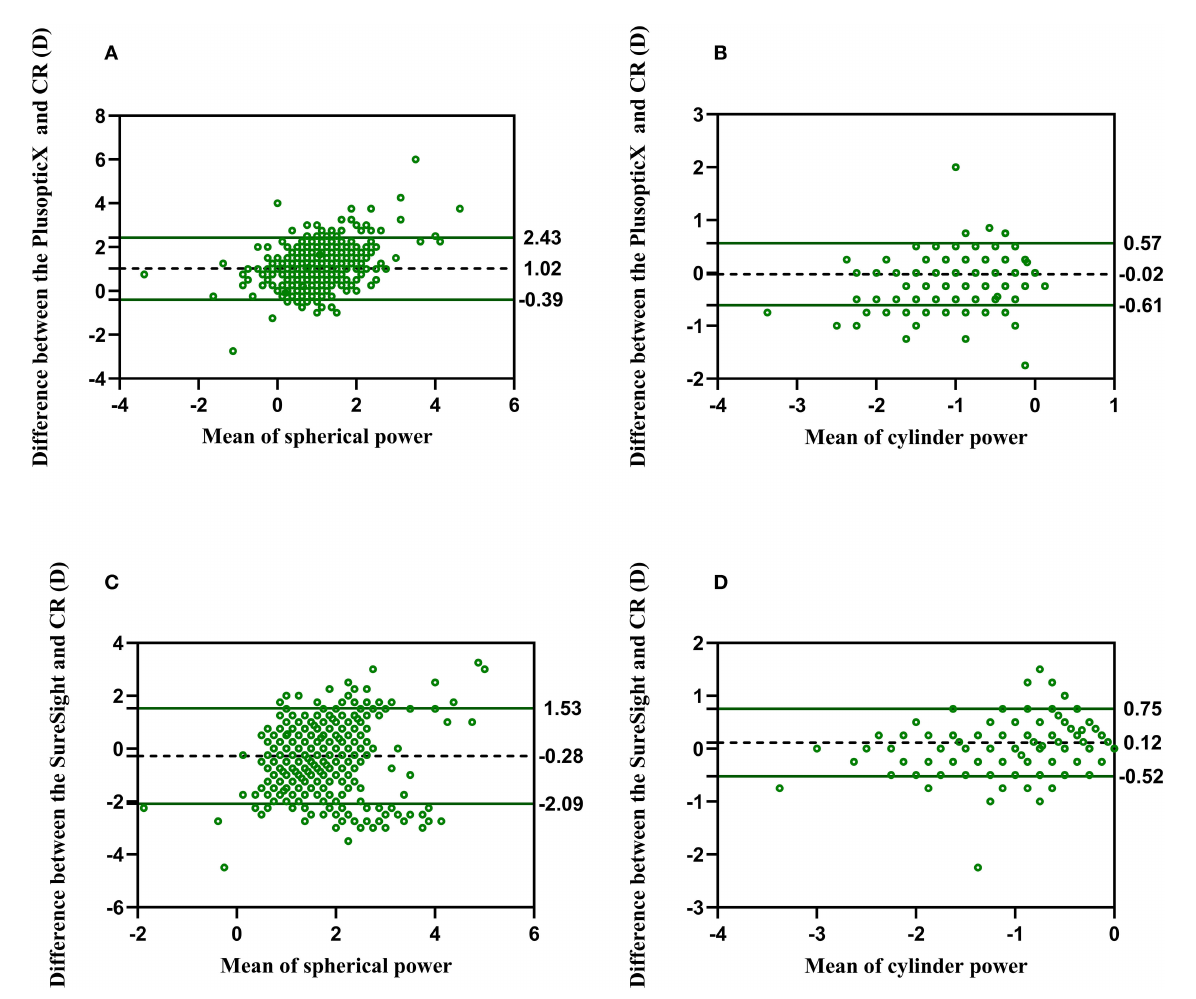
FIGURE1 Bland–Altman plots show the agreement between PlusoptiX, SureSight, and cycloplegia retinoscopy. The difference between sphere and cylinder between (A,B) PlusoptiX and CR and (C,D) SureSight and CR.